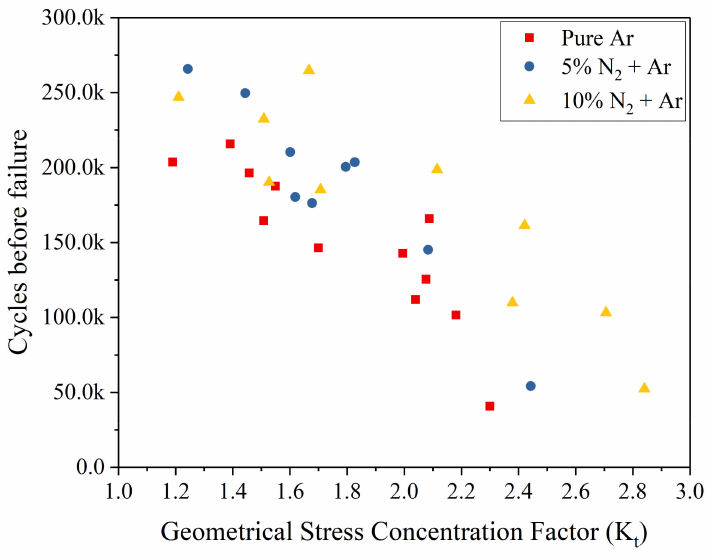
Figure 18. Fatigue life comparison of the welds made using different compositions of shielding gas plotted against the k t obtained using